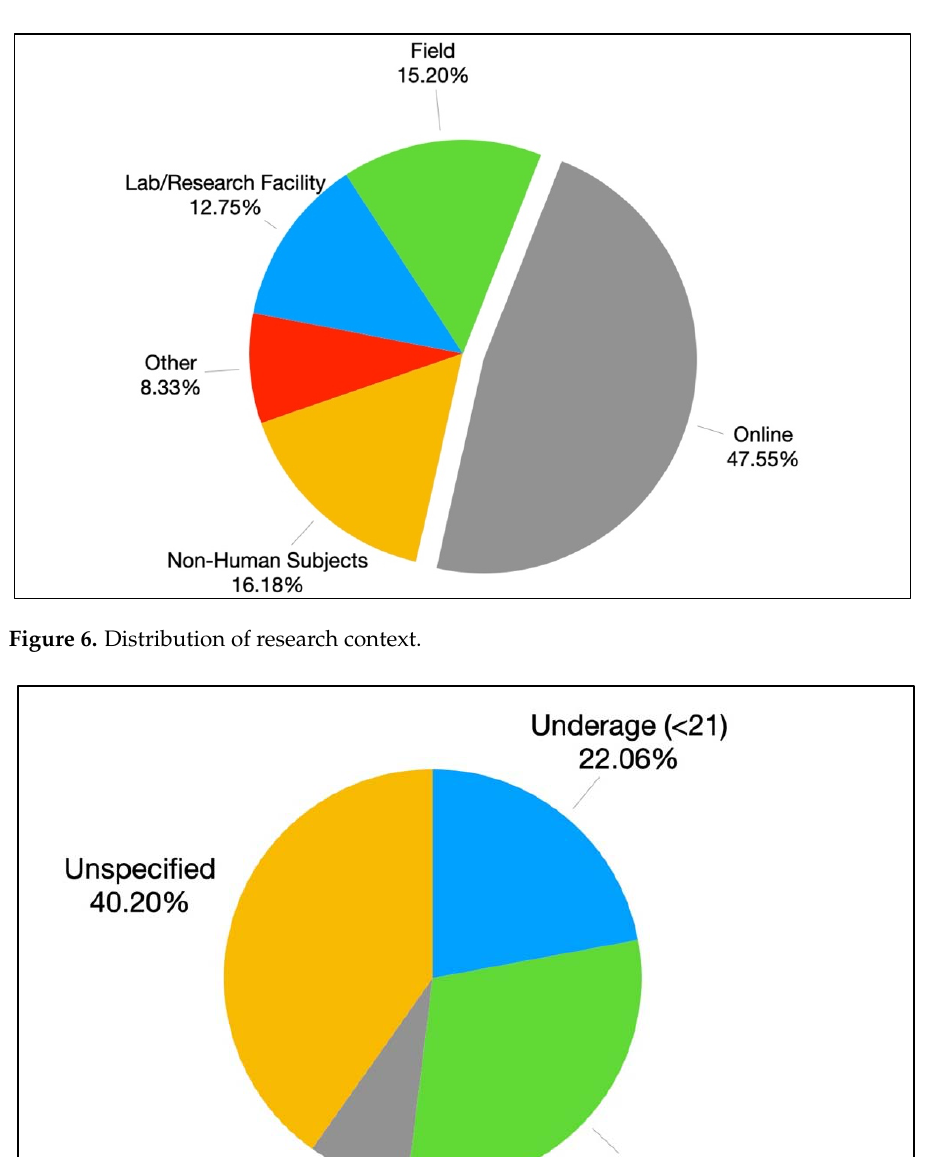
Figure 5. Frequency distribution of articles included in the systematic review, by research method ‐ ology.